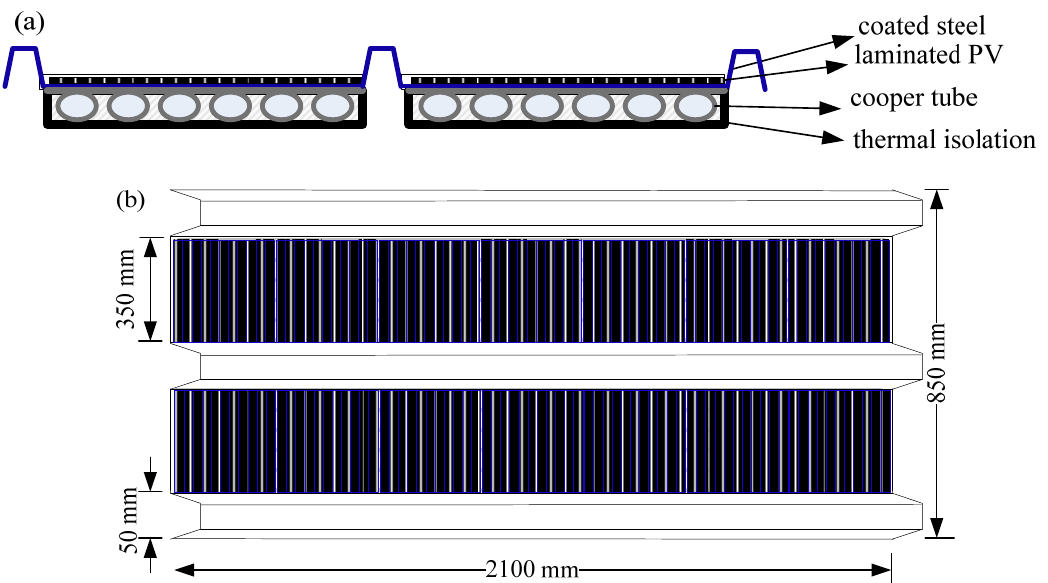
Figure 1. PVT constituent layer: ( a ) Cross-sectional view; ( b ) Top